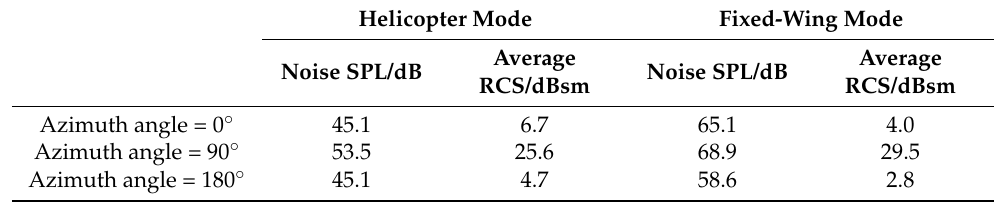
Table 18. Noise SPL and average RCS values with CSM phase parameters of Equations (47)–(50).